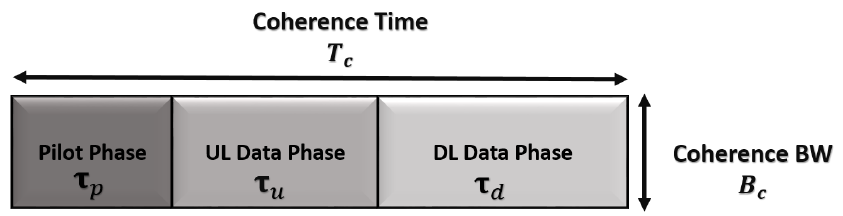
Figure 2. The coherence block in the time division duplex (TDD) protocol, where τ c = T c B c complex-valued